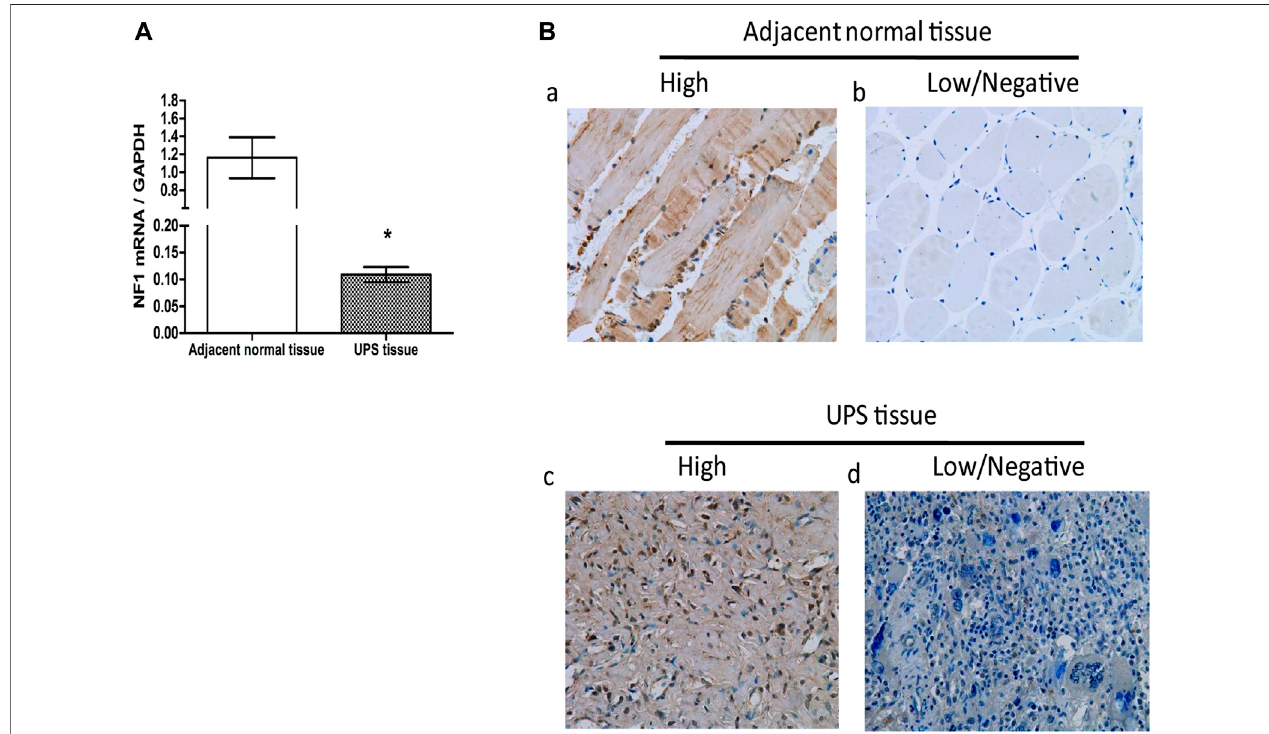
FIGURE 1| Expression ofNF1 in the UPS sarcoma tissue and adjacentnormal tissue. (A) : NF1 mRNA expression in theUPS sarcoma tissue and adjacent normal tissue by qRT-PCR, *: vs. adjacent normal tissue, p < 0.05; (B) Representative images of the protein expression of NF1 in the UPS sarcoma tissue and adjacent normal tissue by immunohistochemistry (200×) (a): High protein expression of NF1 in the adjacent normal tissue; (b): Low or negative protein expression of NF1 in the adjacent normal tissue; (c): High protein expression of NF1 in the UPS sarcoma tissue; (d): Low or negative protein expression of NF1 in the UPS sarcoma